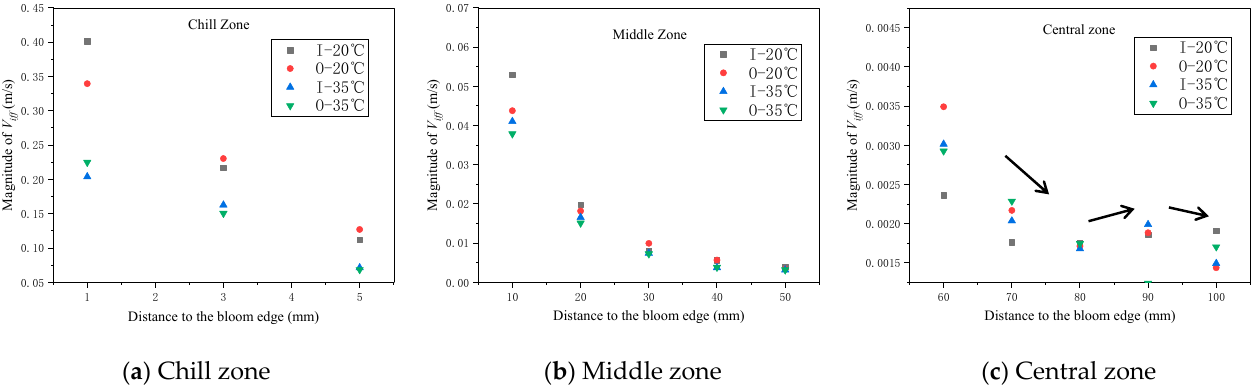
Figure 16. The magnitude of interdendritic fluid flow velocity V if f at different positions in different zones: ( a ) chill zone, ( b ) middle zone, ( c ) central zone. (The velocity magnitude in the central zone decreases firstly, then shows an increasing trend and decreases again finally as shown by arrow line in Figure15c.)